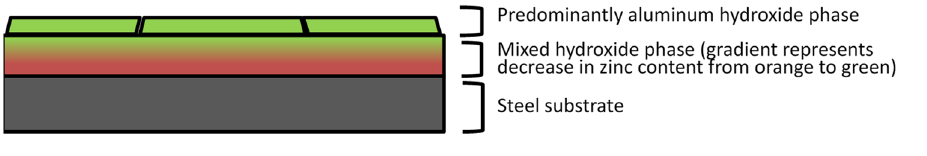
Figure 5. Changing film composition from the substrate to the outer top layer for the electrodeposited zaccagnaite coating.